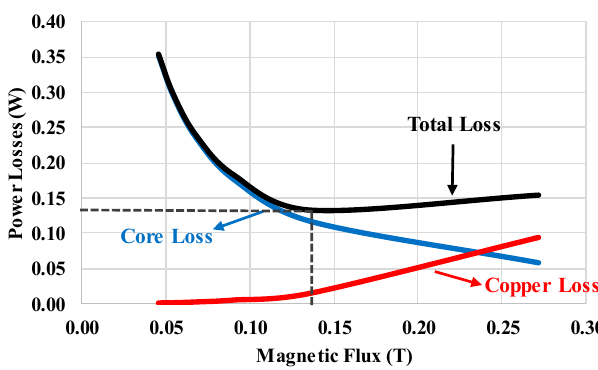
Figure 14. Power losses of the high-frequency power transformer.